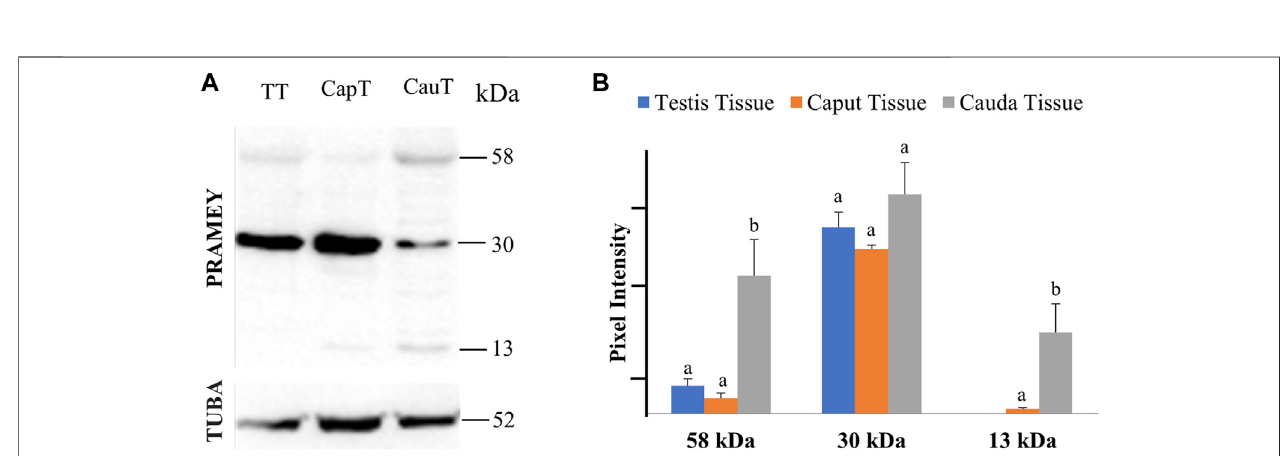
FIGURE 3 | Expression of PRAMEY isoforms in bovine testis tissue (TT) and caput (CapT) and cauda (CauT) epididymal tissues. (A) Immunoblot of total tissue protein in each group probed by PRAMEY antibody and then reprobed by α -tubulin (TUBA) antibody. (B) Quanti fi cation of pixel intensities for the 58, 30, and 13 kDa PRAMEY bands, normalized to the corresponding TUBA. Data are expressed as the mean of the protein pixel intensity ±SEM ( n = 5). Signi fi cance was evaluated between the three types of tissue (testis, caput, cauda) for each PRAMEY isoform (58, 30, and 13 kDa). Values without a common superscript differed ( p < 0.05).